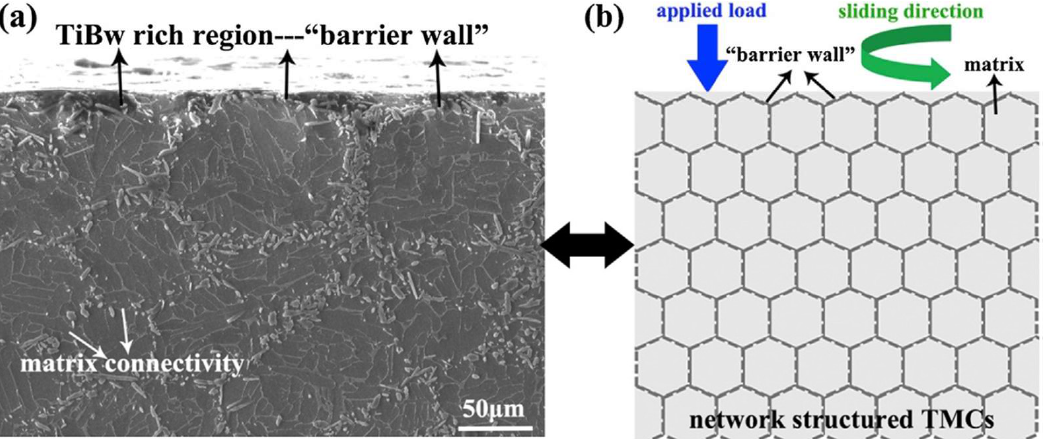
Figure 6. ( a ) Cross section of the worn surface; ( b ) Proposed illustration of the network structured DRTC undergoing sliding wear process [79].